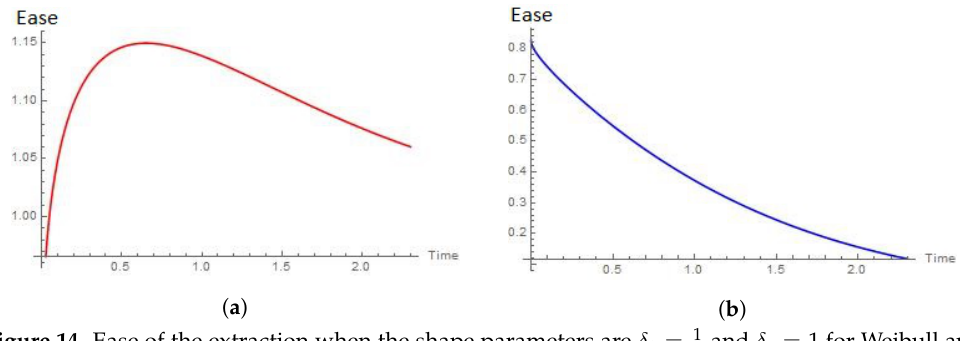
and δ 2 = 1 for Weibull and 2 . ( b ) Ease 2